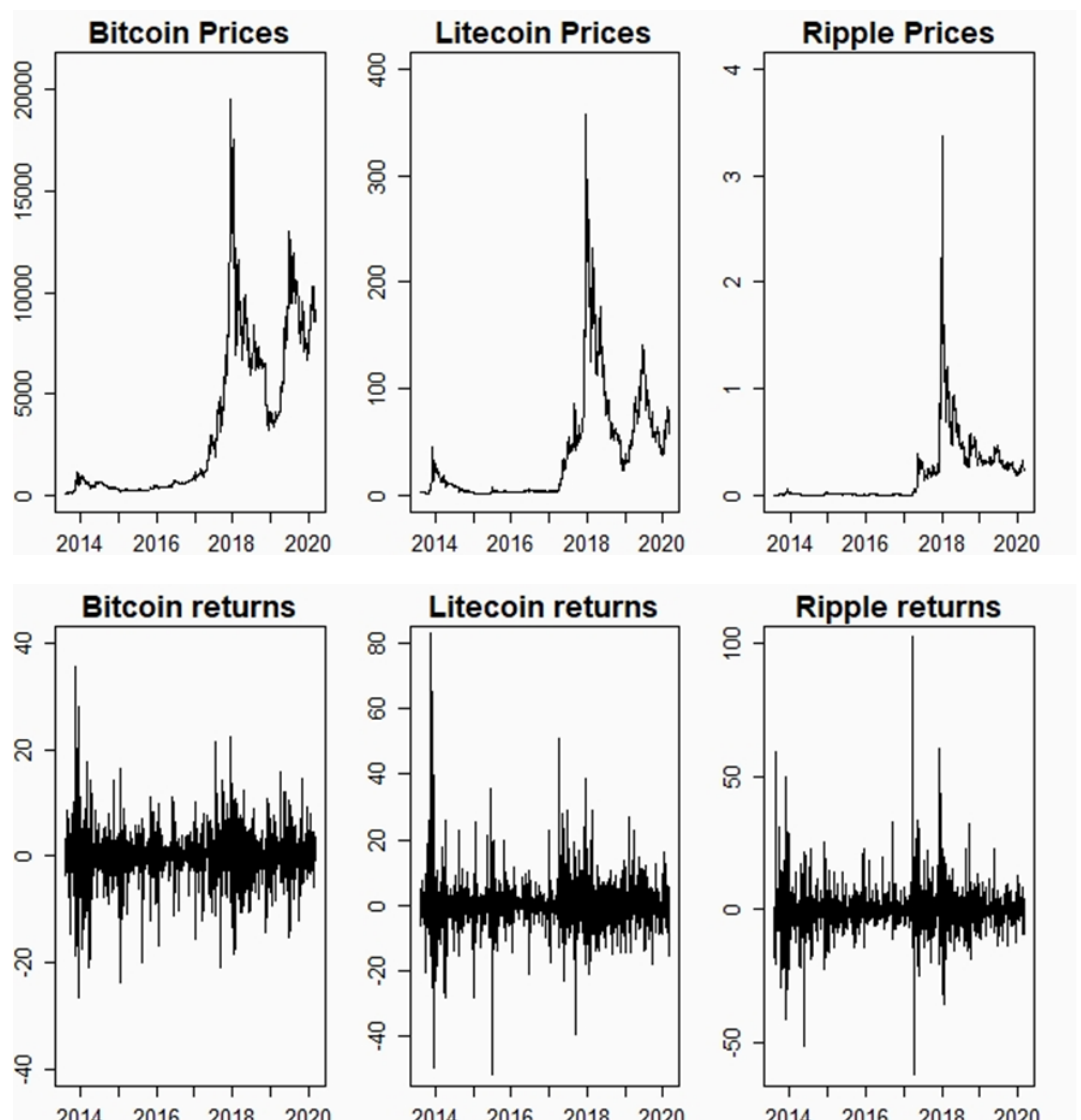
Figure 1. Cryptocurrency prices and returns for Bitcoin, Litecoin, and Ripple series. Daily prices from August 4th, 2013 to March 6th, 2020 (2407 observations).